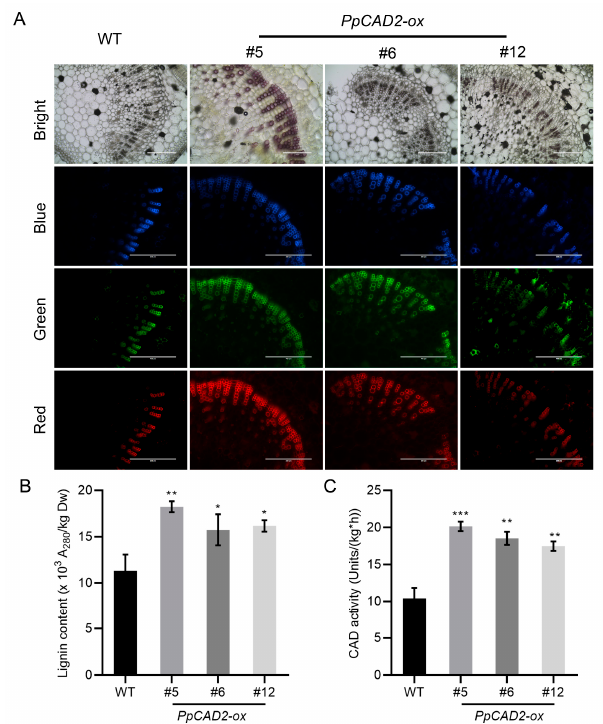
Figure 4. PpCAD2 increases the lignin content and CAD enzyme activity in the leaves of transgenic tomato plants. ( A ) Autofluorescence of transverse slice in the leaf veins, Bright: bright field images, Blue: blue autofluorescence, Green: green autofluorescence, Red: red autofluorescence. Scale bars = 200 µ m; ( B ) The lignin content of leaves in the WT and transgenic plants; ( C ) The CAD enzyme activity in the leaves of WT and transgenic plants. In ( B ) and ( C ), the data represent the mean ± SD (standard deviation) from three biological replicates. Significant di ff erences between the wild-type and transgenic plants are indicated (* P < 0.05, ** P < 0.01, *** P < 0.001, Student’s t-test ). CAD genes were demonstrated to control lignification in plants [39–41]. In agreement with our results, Brachypodium distachyon CAD gene BdCAD1 mutants displayed a reduced CAD activity and lower lignin content [39], suggesting that the CAD activity is positively correlated with the lignin content. In Brassica chinensis , the induced expression of BcCAD1-1 and BcCAD2 could increase